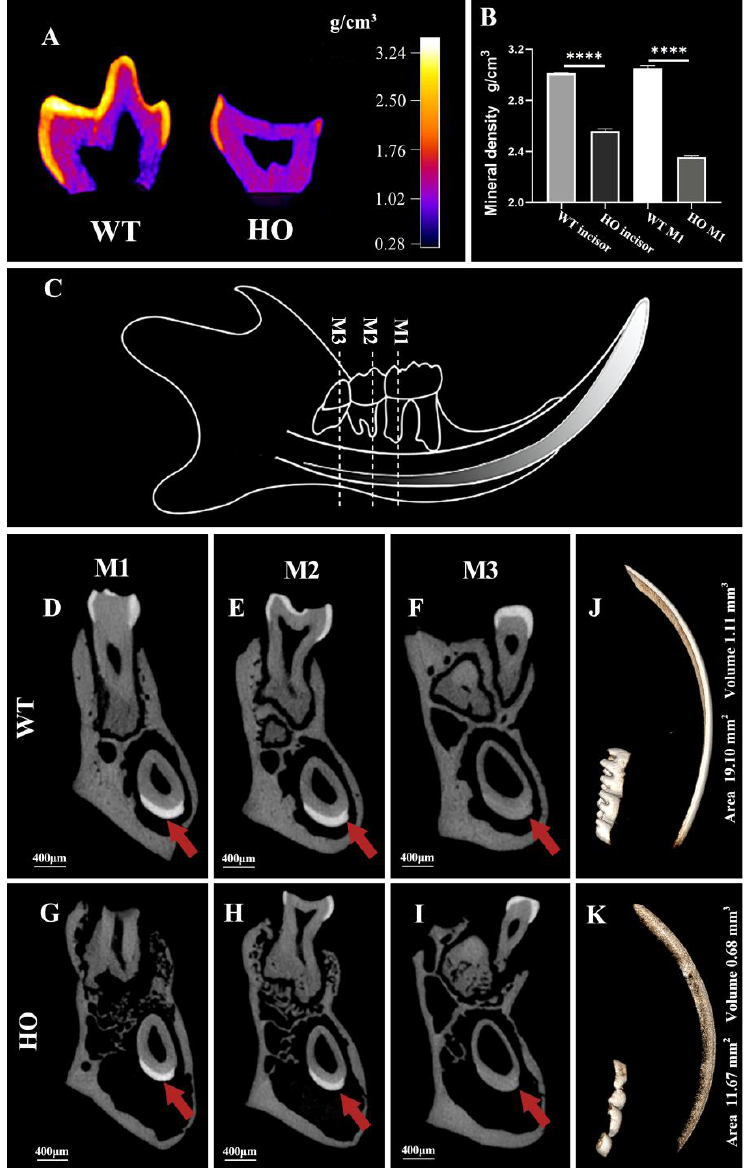
Figure 5. Micro-CT analysis of enamel from WT and HO mice: ( A ) False color plots showed that the enamel of the WT mice molar was generally thick and mineralized gradually, with the surface enamel being the most mineralized and the EDJ the least, generating a well-demarcated margin; the enamel of HO mice was thinnish and more radiolucent and did not show a distinct boundary. ( B ) There was a significant difference in the enamel mineral densities between the WT and HO mice incisors and molars: **** p < 0.0001. Error bars denote mean ± SEM. ( C ) The diagram with dotted lines points out the chosen positions of the transverse section of the mandible in mice. ( D – F ) In the WT mice, the enamel layer mostly covered the crown of the molars and the labial aspect of the incisor, where it slowly decreased in thickness and radio-opaque from tip to apical. ( G – I ) In the HO mice, the enamel on the molars was barely visible and that on the incisors was flimsy and dim (arrowheads). ( J , K ) Representative 3D micro-CT reconstruction of the hemimandibles was presented with a threshold cutoff at which only highly mineralized structures were seen. The volume and area of the high threshold region of the WT sample were 19.10 mm 3 and 1.11 mm 2 . The volume and area of the high threshold region of the HO sample were 11.67 mm 3 and 0.68 mm 2 .